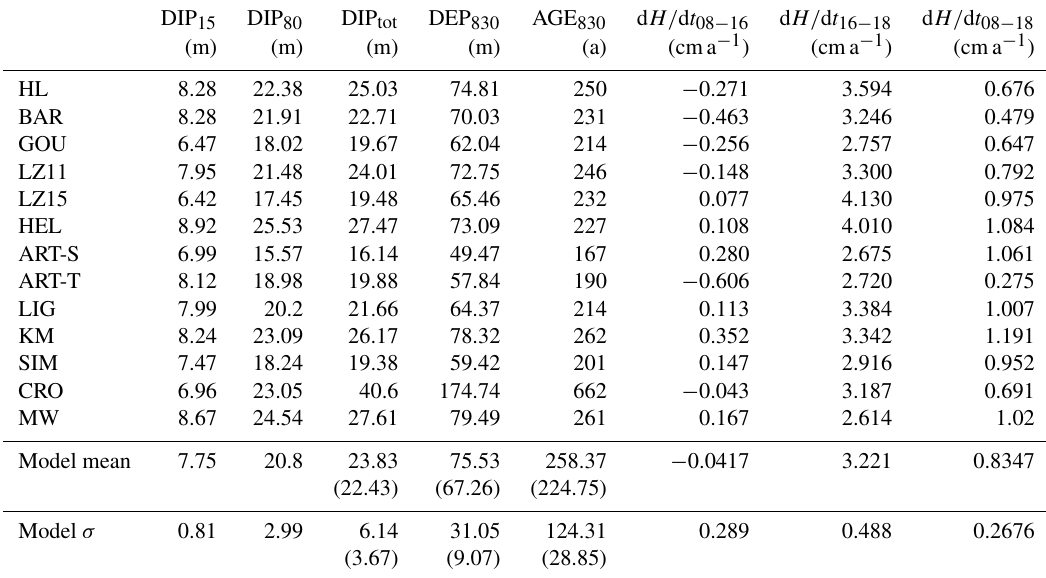
Table 3. Model results, including DIP at 15 and 80m of depth and the bottom of the model domain ( ∼ 220–230m); the depth and age of the 830kgm − 3 density horizon; and the linear trend in surface elevation change (i.e., a regression of the model results shown in Fig. 2) in the last 10 years of the model run (2008 to 2018). The “Model mean” and “Model σ ” rows show the statistics for all 13 models; the values in parentheses are the statistics excluding CRO, which predicts anomalously low densification rates in the deeper firn. DIP